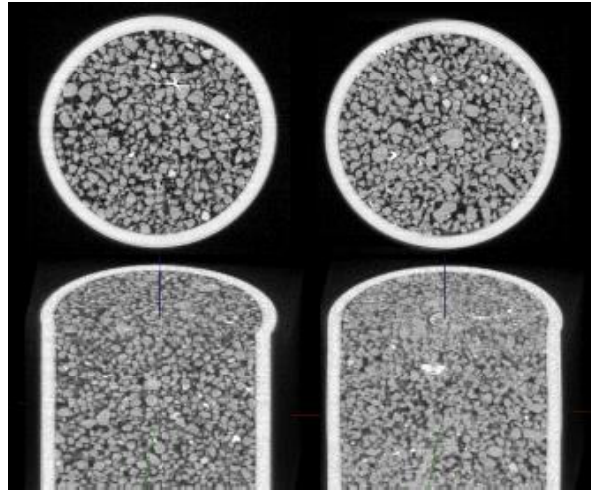
Figure 1. Cross-sectional and three-dimensional images of soil core samples for bulk density 1.51Mgm − 3 (left panel) and 1.72Mgm − 3 (right